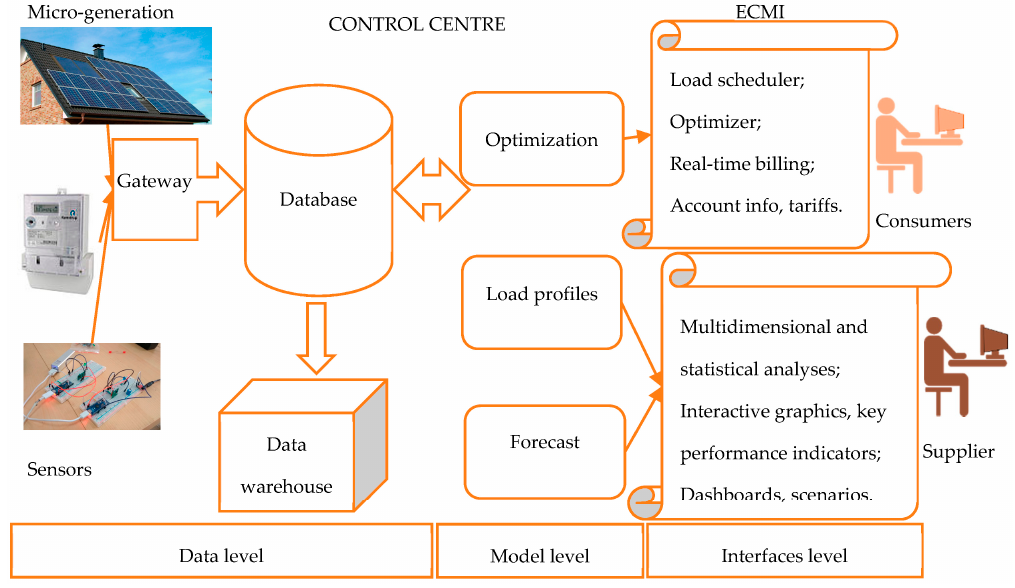
Figure 2. Architecture of the prototype.